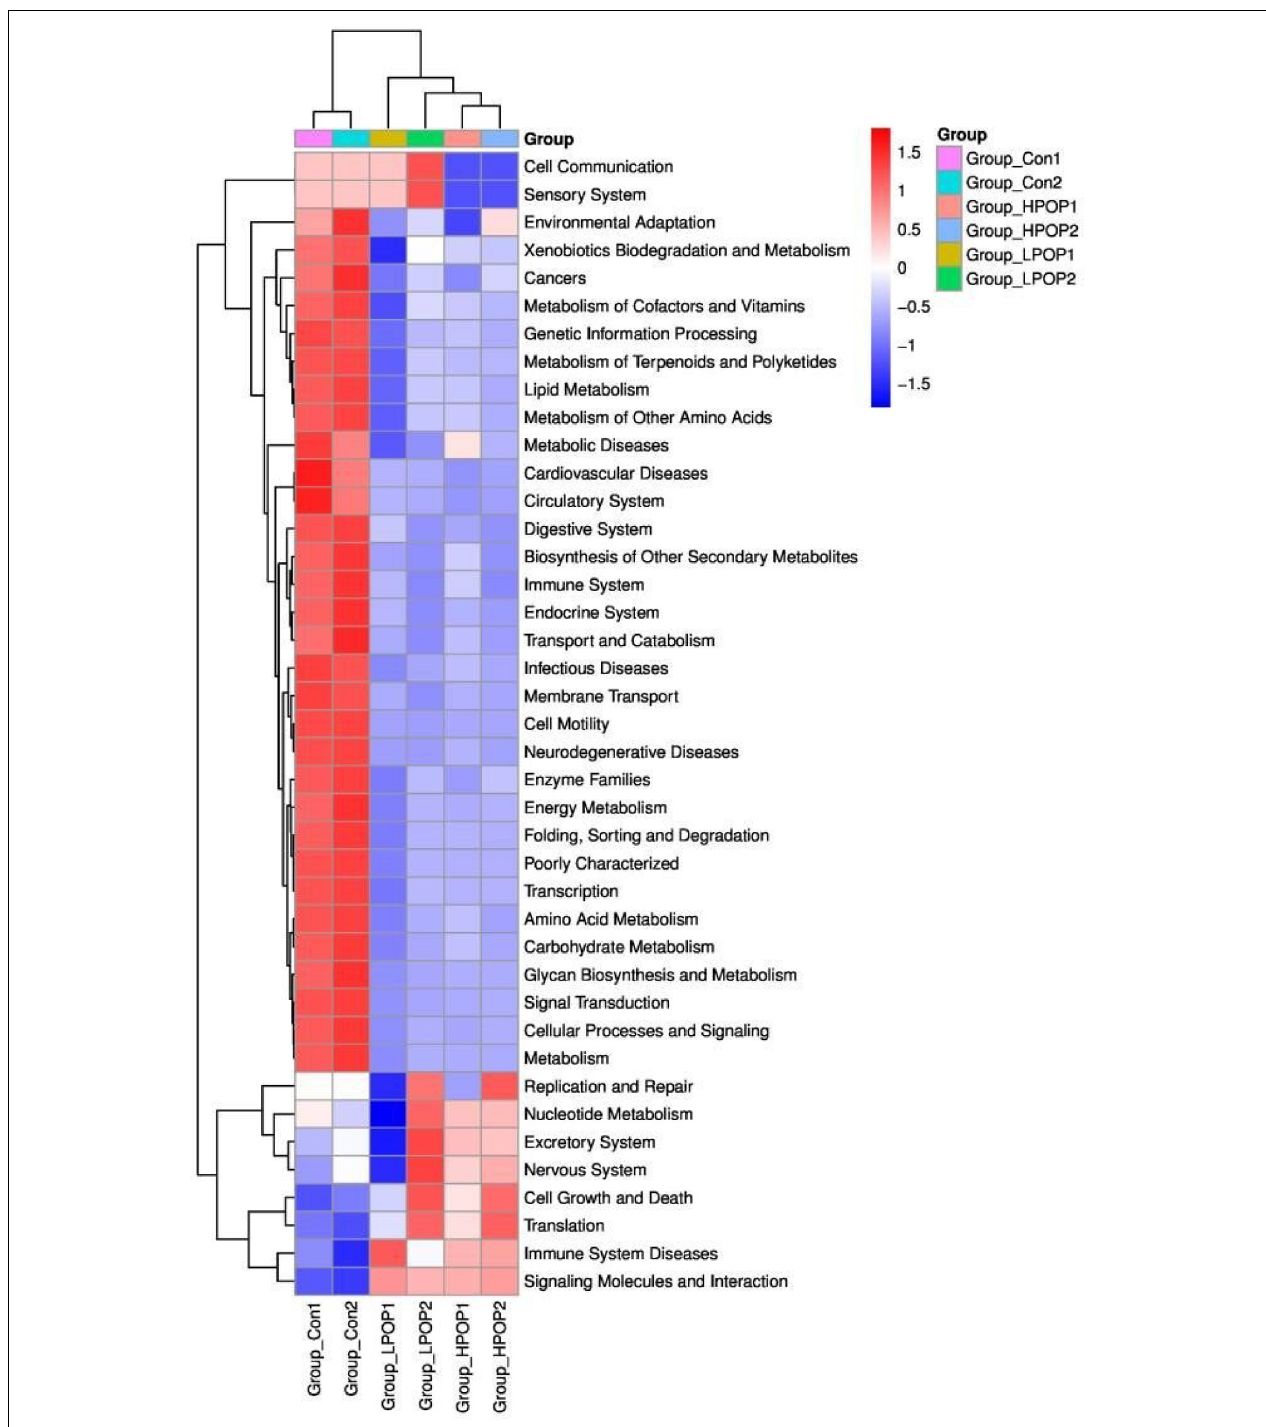
FIGURE 8 | The heatmap showing the PICRUSt-predicted KEGG ortholog (KO) functions among the Con1, Con2, LPOP1, LPOP2, HPOP1, and HPOP2 groups in in vitro fermentation.